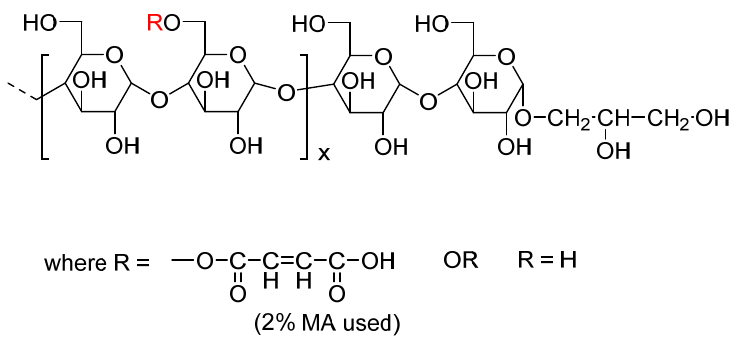
Figure 1. Structure of maleated thermoplastic starch (MTPS).